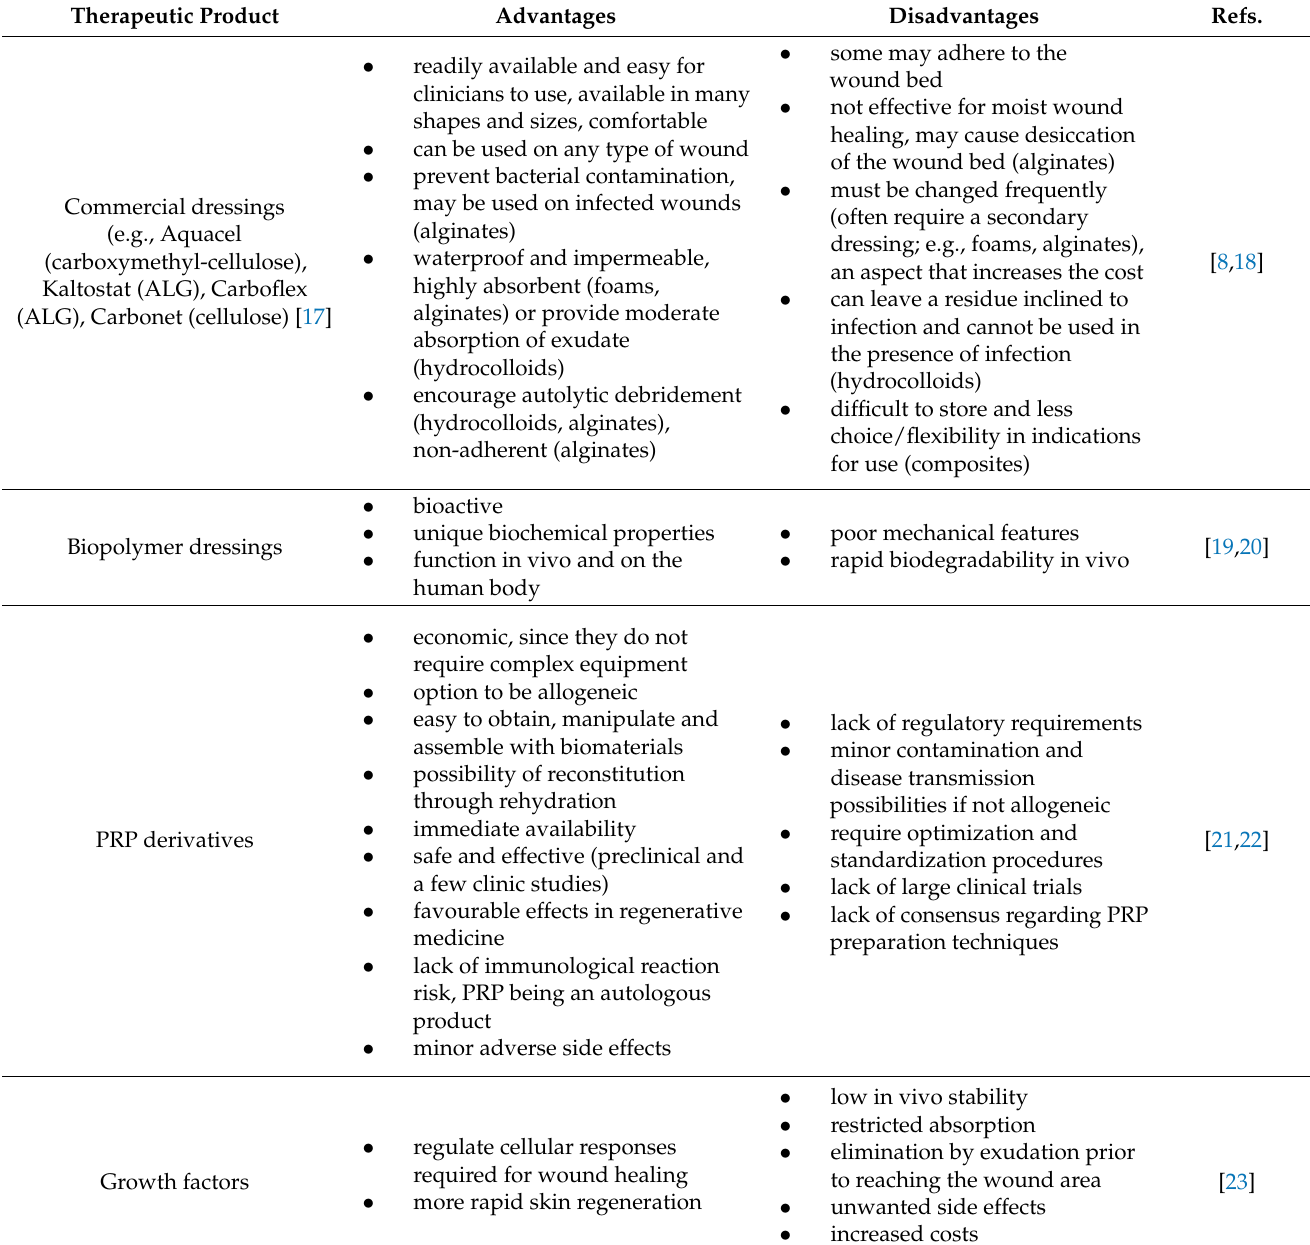
Table 1. Summary of various current wound healing approaches. Therapeutic